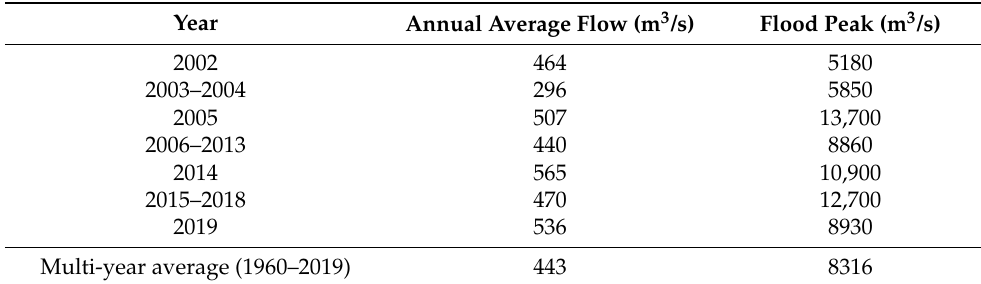
Table 3. Upstream water inflow in different years.